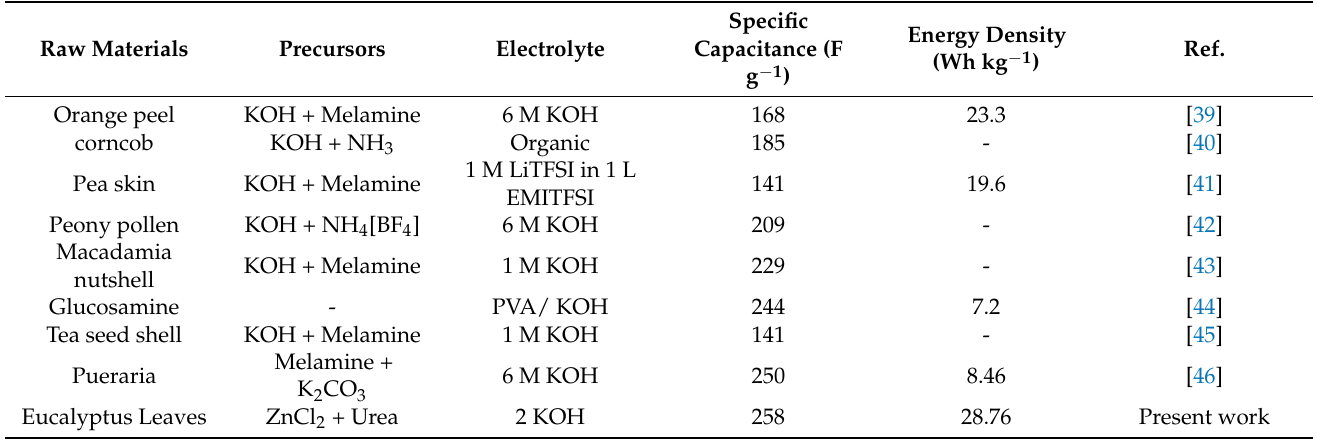
Figure 6. GCD graph of AC an NAC at various temperature ( a ) GCD of AC and NAC at a current density of 0.25 A g − 1 , ( b ) GCD curve of AC-700 ◦ C, ( c ) GCD curve of NAC-700 ◦ C, ( d ) effect of temperature on specific capacitance from GCD. Table 2. Comparison of electrochemical performance NAC derived from different